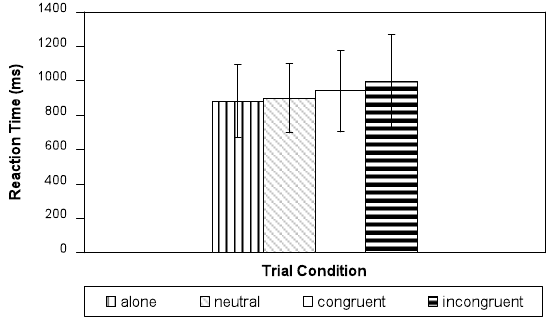
Figure 1 : Mean reaction times of the four conditions of the interference control task; error bars depict standard deviations.